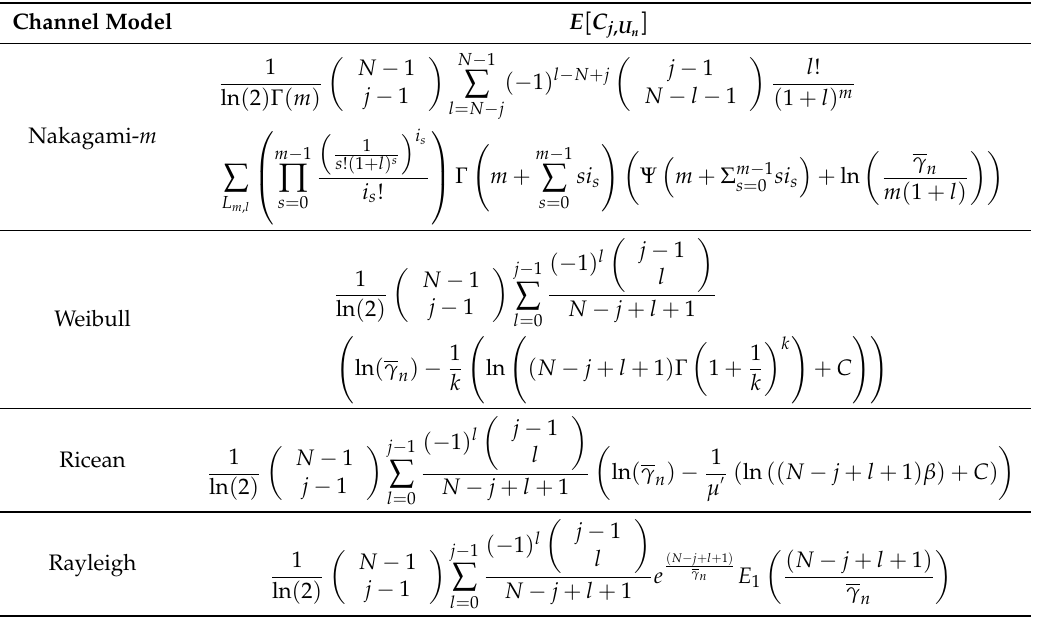
Table 6. ECC of a single user obtained by